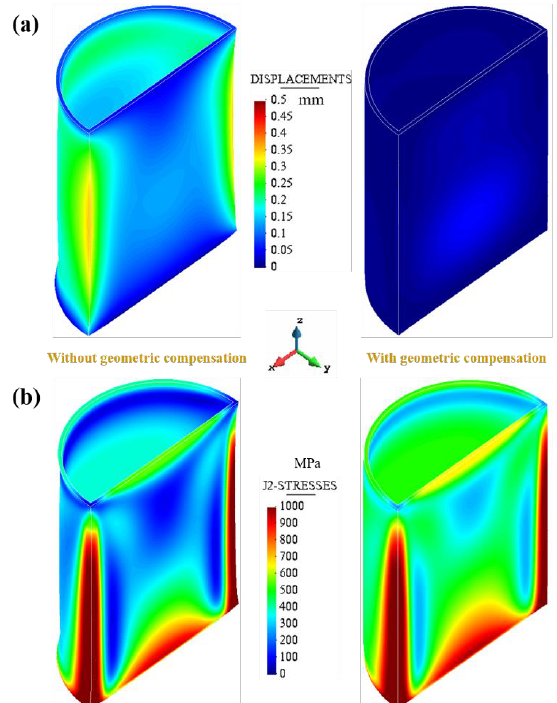
Figure 18. One integrated component from Figure 17 without and with geometric compensation: ( a ) distortions; ( b ) residual